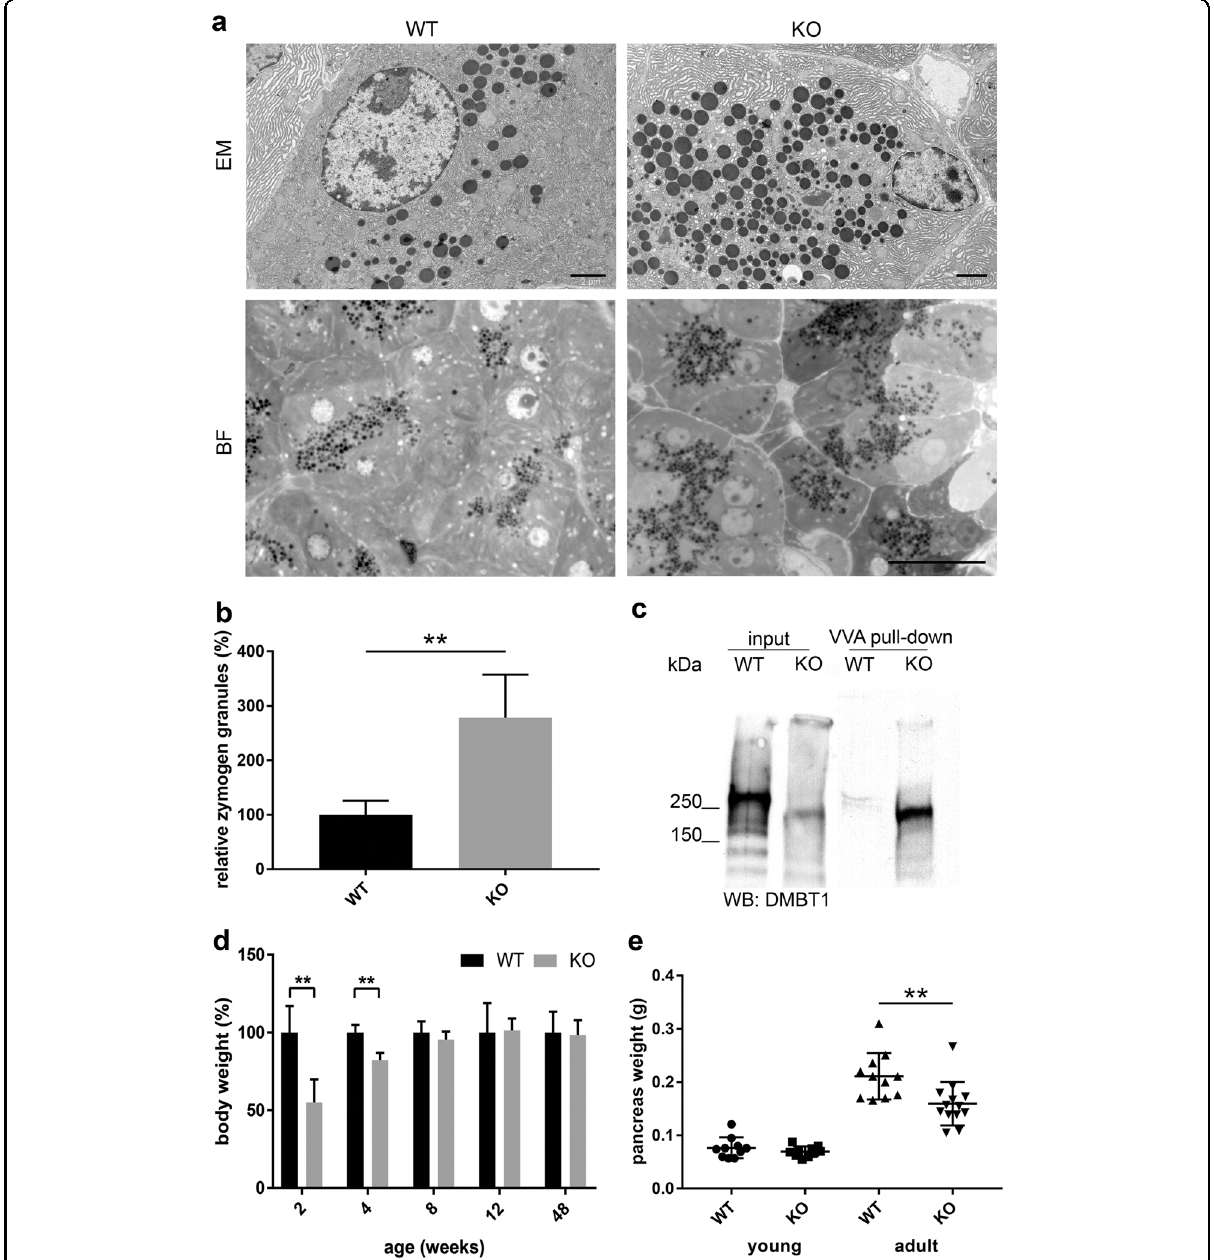
Fig. 3 Cosmc de fi ciency results in accumulation of zymogen granules and pancreas atrophy in aged mice. a Representative TEM and bright fi eld micrographs of pancreas sections from fasting WT and Cosmc -KO adult mice. Zymogen granules are depicted as electron dense vesicles. TEM and BF scale bars are 2 and 20 µm, respectively. b Quanti fi cation of zymogen granules in fi ve randomly selected fi elds of pancreas sections from fasting WT and Cosmc- KO adult mice ( n = 5 each). Elevated numbers of zymogen granules in Cosmc- KO pancreata ( P = 0.0004). c WB of VVA pull- down from WT and Cosmc- KO pancreatic lysates and DMBT1-speci fi c antibody for detection. d Body weight analysis of WT and Cosmc- KO mice at ages 2 – 48 weeks ( n = 10 each) displays reduced body weight gain at 2 and 4 weeks of age ( P = 0.0021 and P = 0.0002). e Assessment of pancreas organ weight of 20- ( n = 10) and 54-week-old WT ( n = 11) and Cosmc- KO ( n = 13) mice. Aged mice display reduced organ weight ( P =